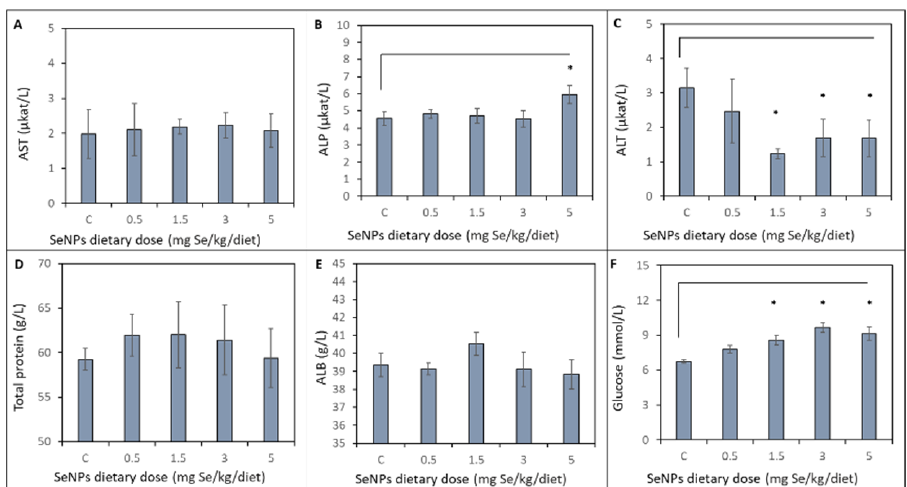
Figure 3. Biochemical profile of liver of control group (C) and after SeNP dietary intake determined from the blood. The activity of liver enzymes: ( A ) AST ( B ) ALP, ( C ) ALT. The concentration of ( D ) Total protein, ( E ) ALB and ( F ) Glucose. * Mean values were significantly different ( p < 0.05). Details of measurement are described in the Materials and Method section.